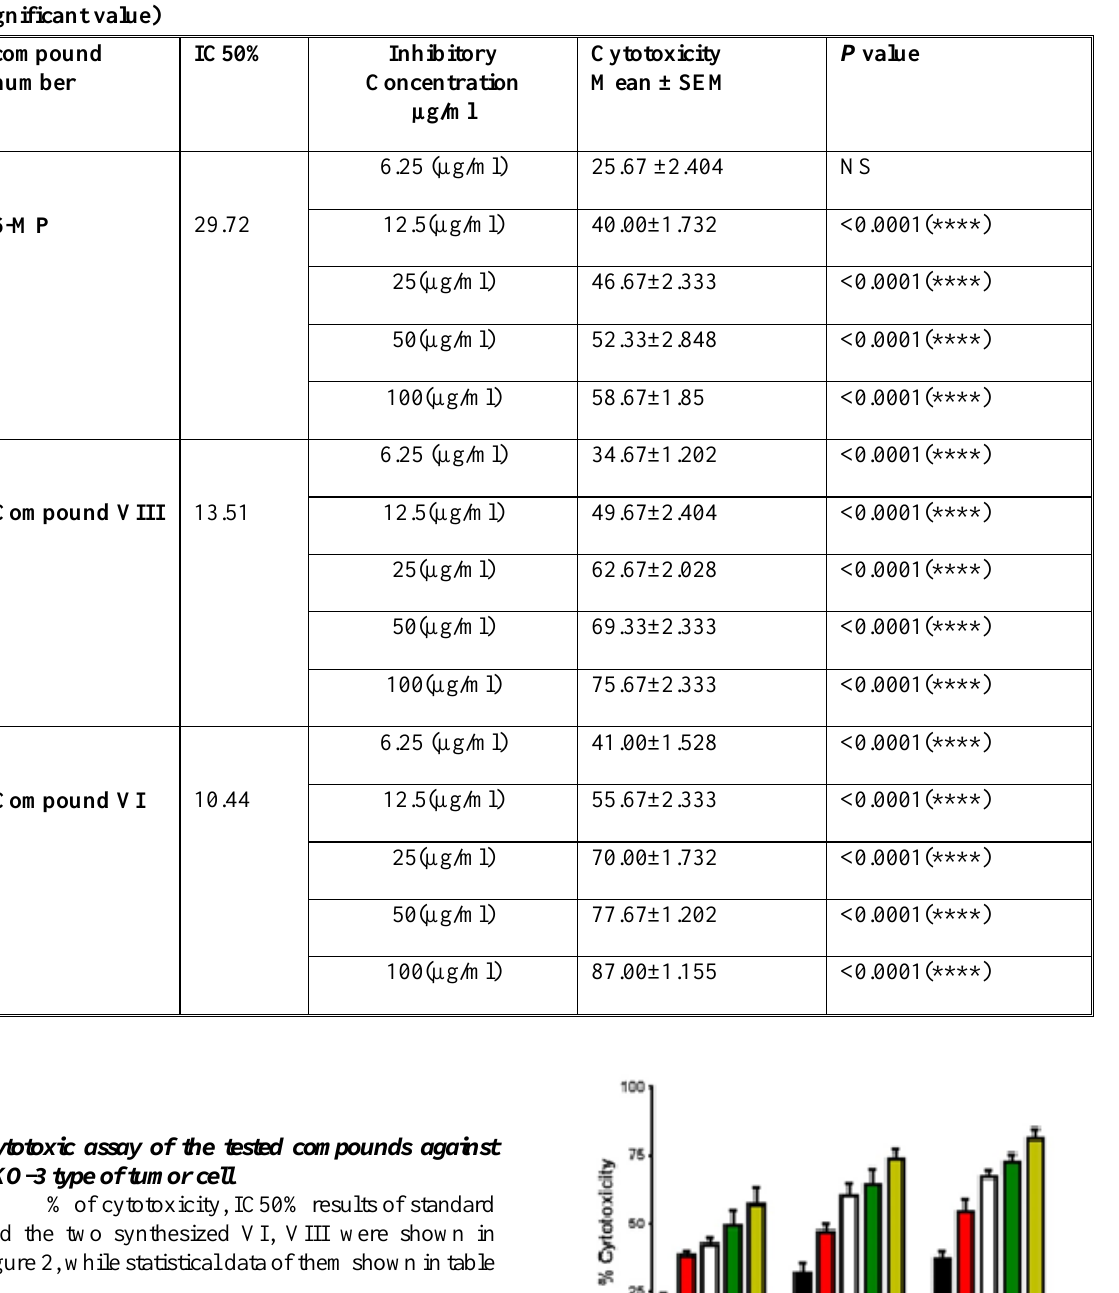
Table ( 1) Cytotoxic activity of 6-MP, compound VIII and compound VI against MCF-7 cancer cell (*Mean ±SEM is mean and standard error of mean, P value is probability value, NS: non-significant value, ****